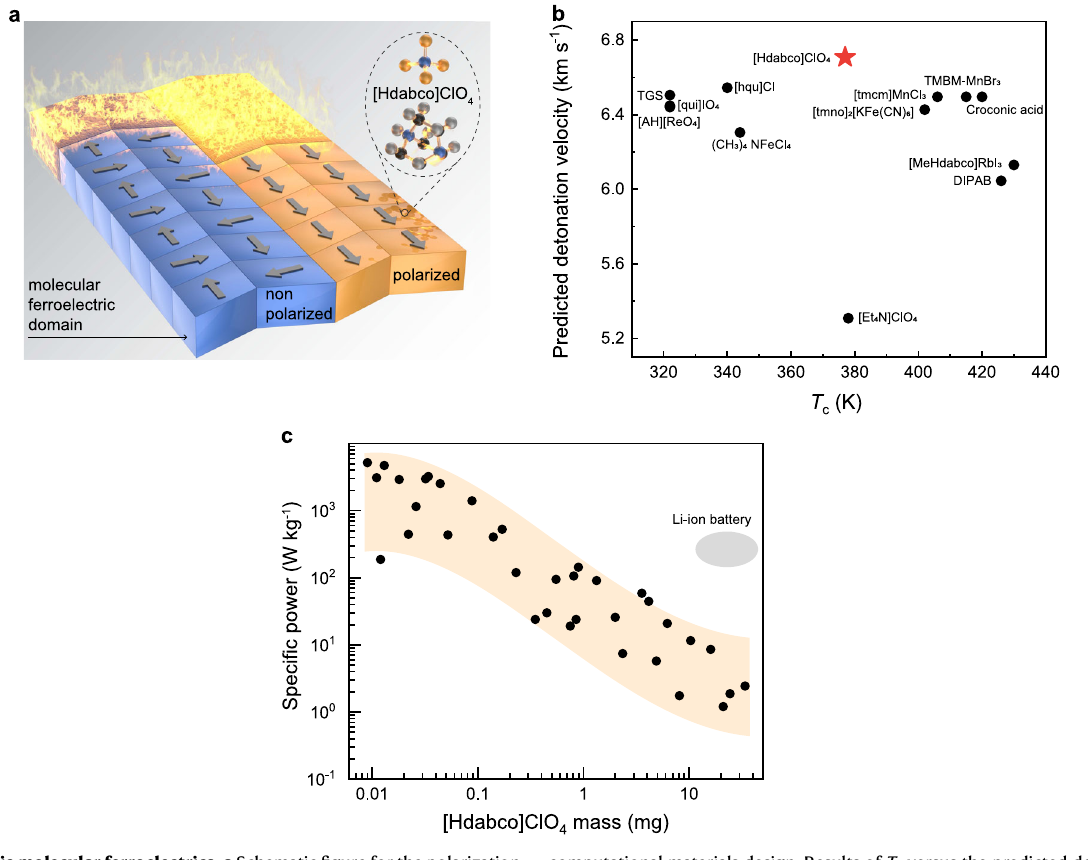
computational materials design. Results of T c versus the predicted detonation for molecular ferroelectrics from machine learning models. c The mass dependent speci fi cpeakpowerforenergetic[Hdabco]ClO 4 .Thespeci fi cpowerisenhancedat the low-mass devices due to the larger surface